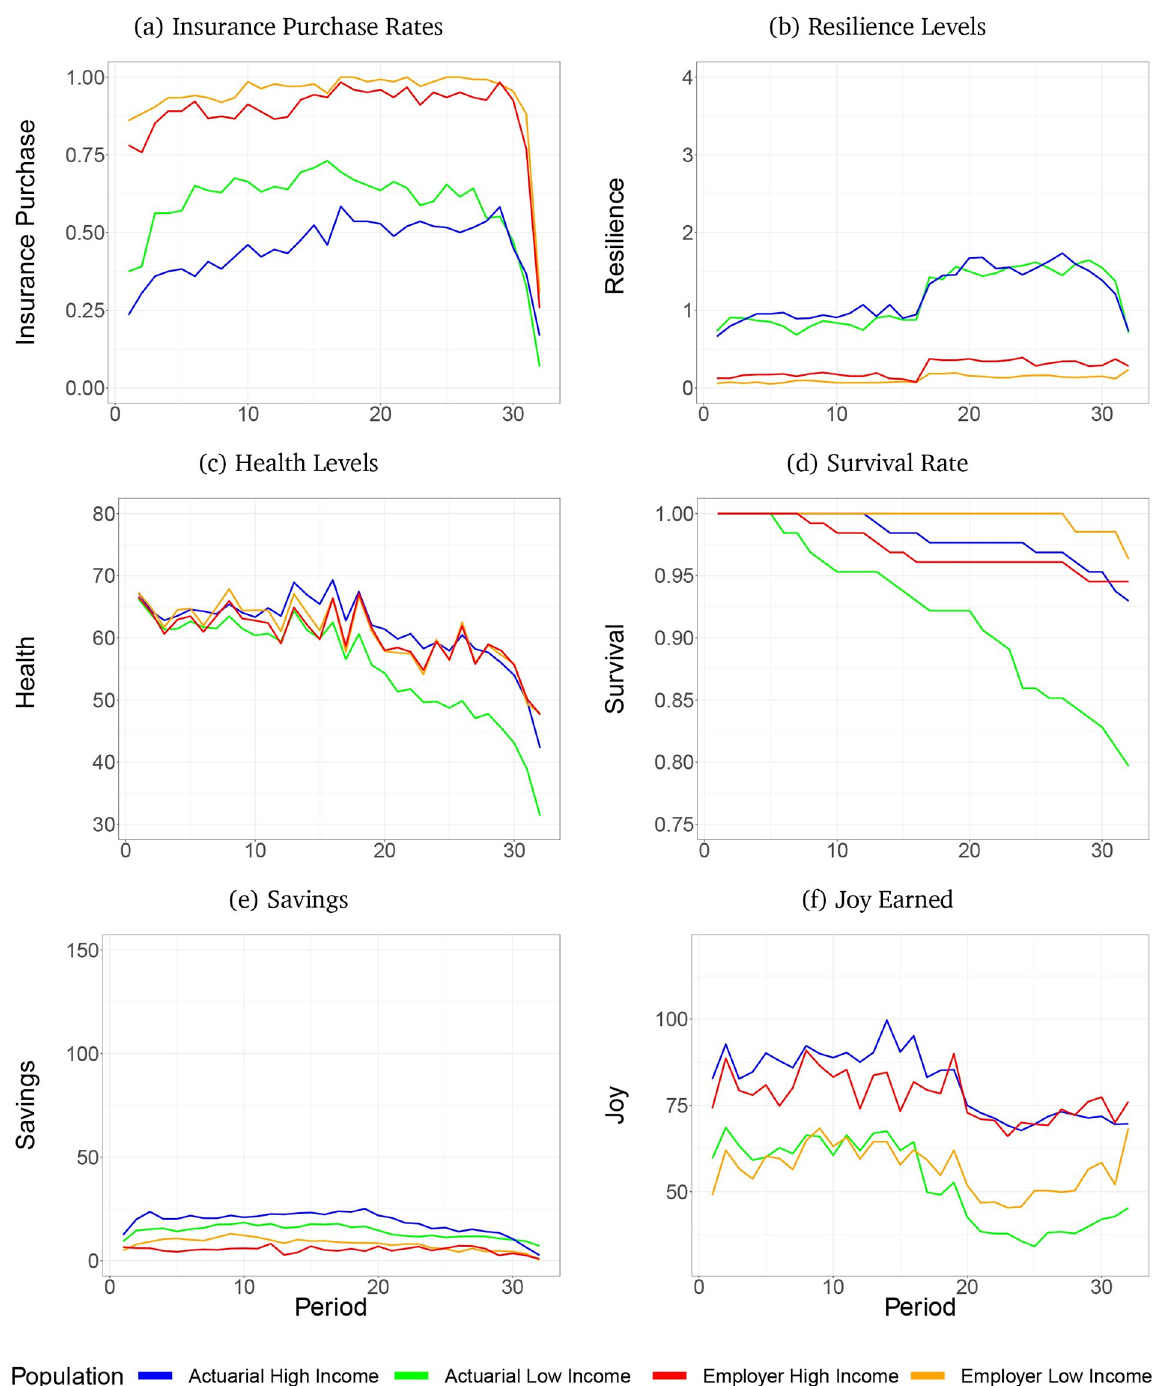
Fig 4. Results from subjects. Includes panels: (a) Insurance purchase rates, (b) Resilience levels, (c) Health levels, (d) Survival rate, (e) Savings, (f) Joy earned.